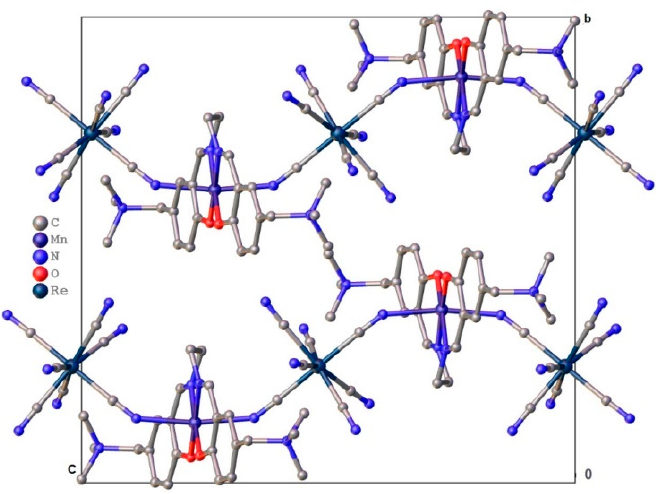
Figure 12. View of the chains in 12 projected along the a axis. Hydrogen atoms and interstitial water molecules are omitted for clarity [46].